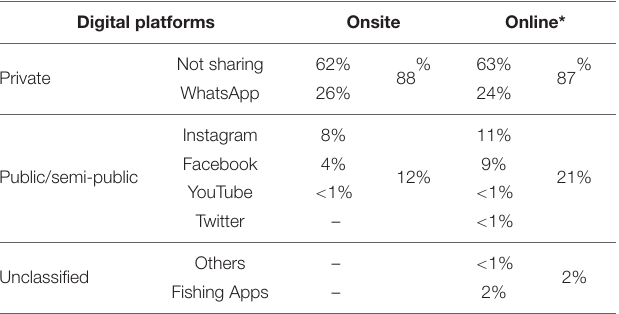
TABLE 2 | Percentage of recreational fishers sharing and not sharing their catches on digital platforms for online and onsite survey respondents. Digital platforms Onsite